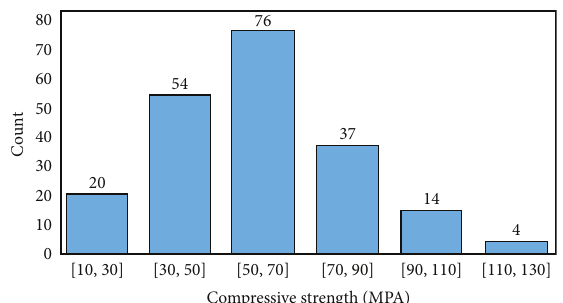
Figure 3: Shows the histogram for specimens’ 28-day compressive